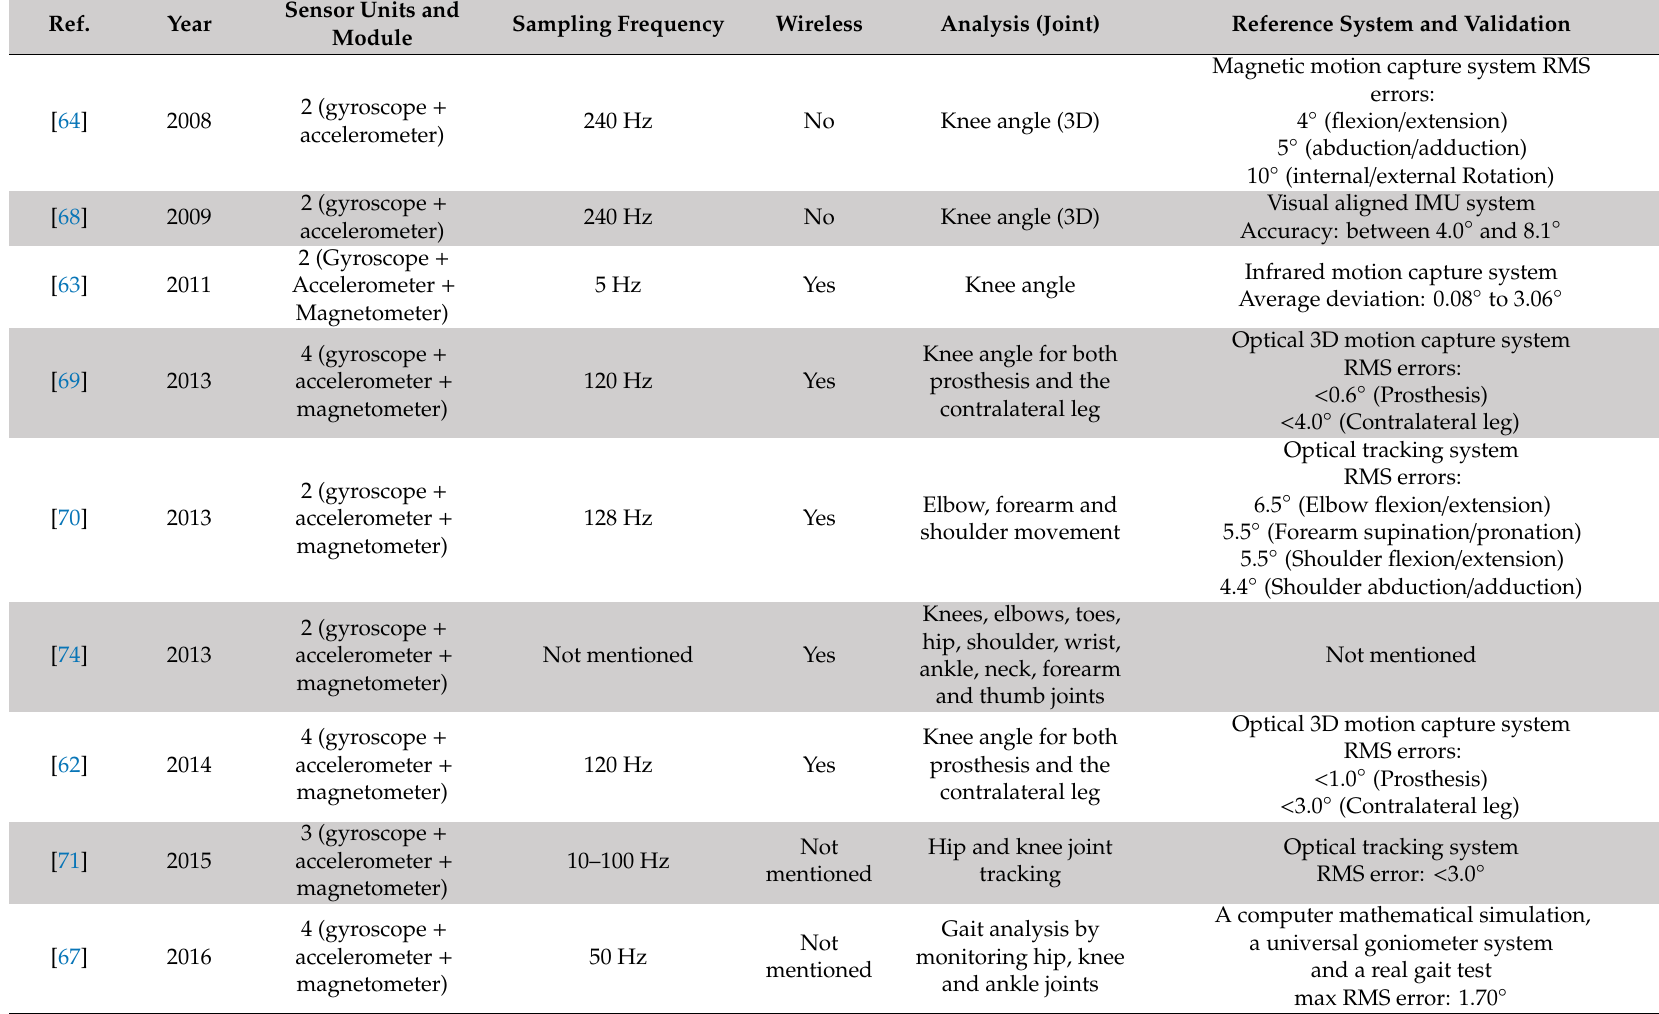
Table 4. Listing of published inertial measurement unit (IMU)-based joint monitoring techniques, analysis and validation methods.